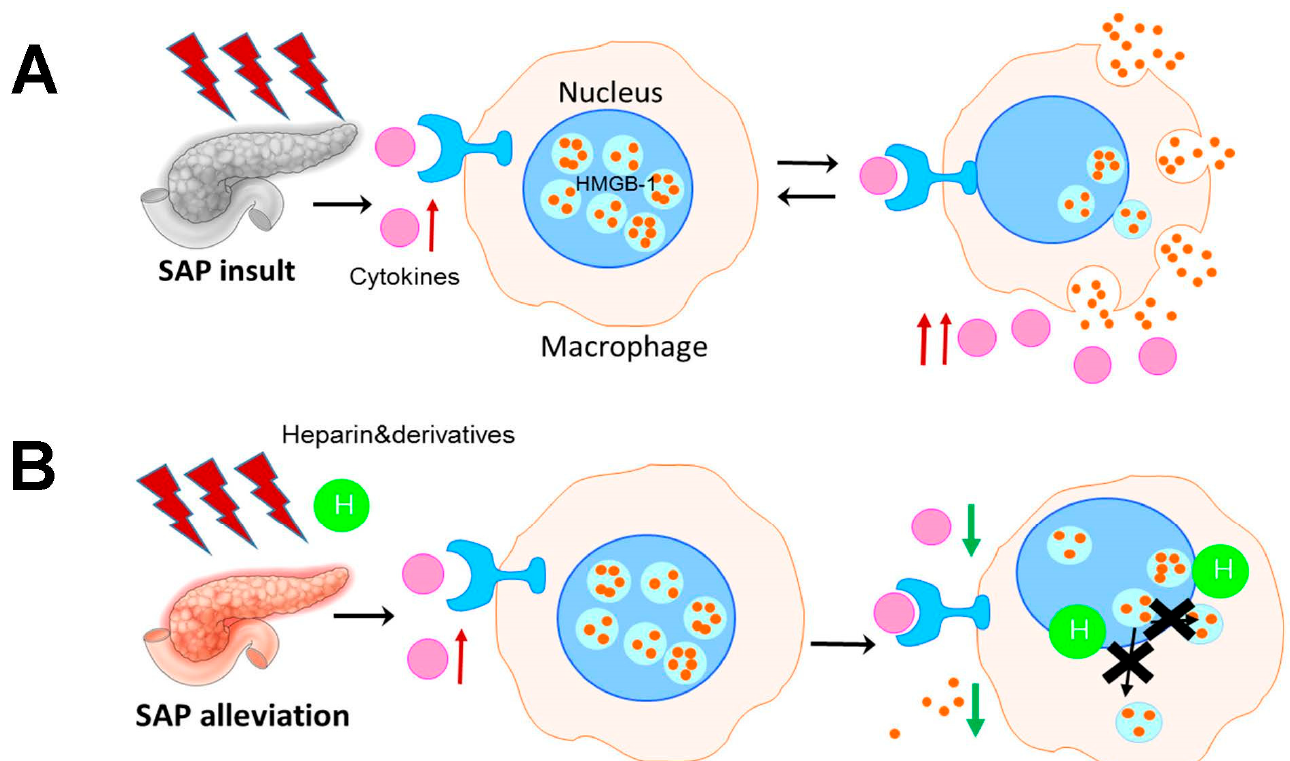
Figure 1. The mechanism through which heparin and derivatives exert effects on SAP. ( A ) Extracel- lular HMGB-1 secreted from activated macrophages drive the inflammatory exacerbation and lead to acinar necrosis in SAP. ( B ) Heparin and non-anticoagulant derivatives alleviated the disease by blocking the allotopia of HMGB-1 from the nucleus of macrophages, thereby inhibiting the secre- tion.